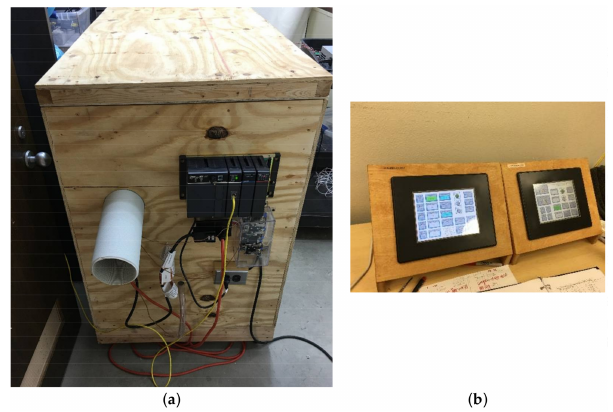
Figure 3. Environmental chamber test setup ( a ) Controller attached to box chamber and ( b ) snapshot of the